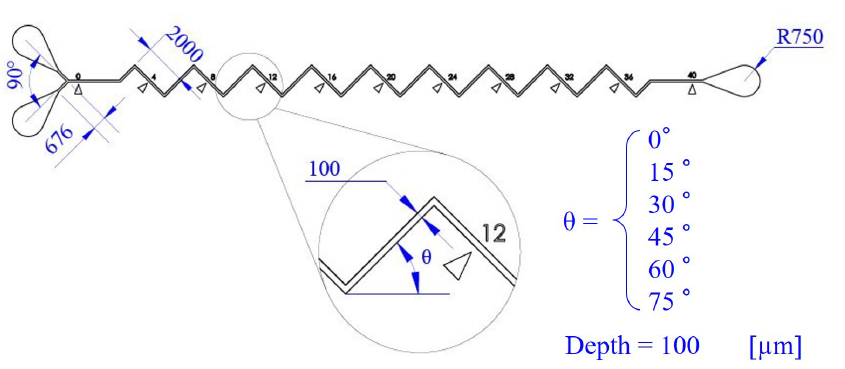
Figure 3. The dimensions of the zigzag channels used in experiments. Channels with six different zigzag angles θ are fabricated while all the other dimensions are kept the